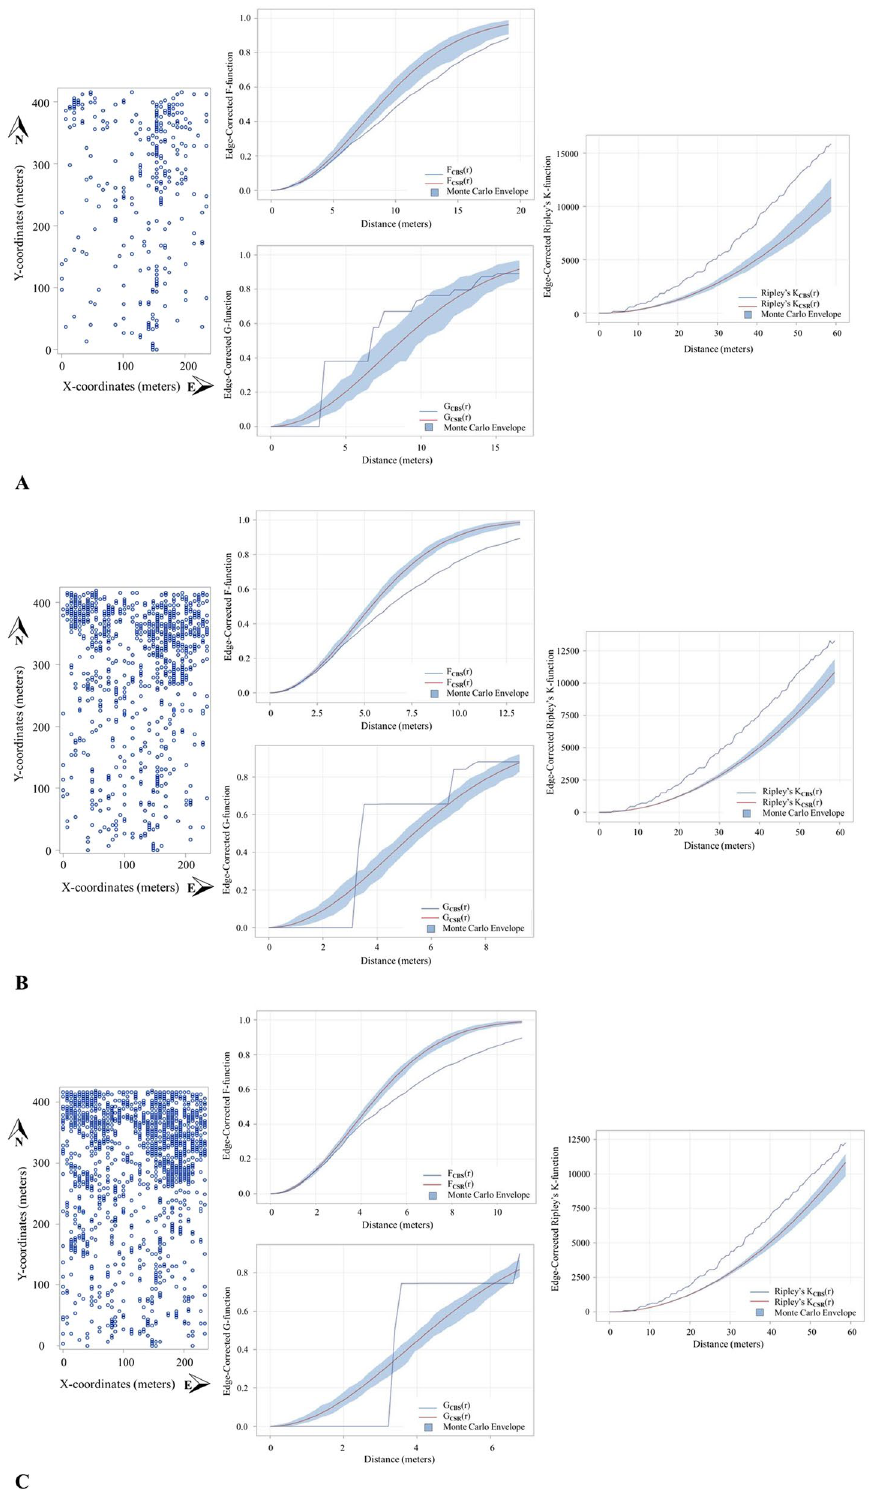
Figure 2. Grove II point pattern analyses. Comparisons of point pattern analyses for Groves II for three contiguous citrus seasons (Panel A) 2013–2014, (Panel B) 2014–2015 and (Panel C) 2015–2016. Each panel consists of a plot map of CBS positive trees (open circles; left), edge-corrected F- and G-functions (middle) and edge-corrected Ripley’s K-function (right). Positive trees contain at least one fruit with a single hard-spot lesion. Values of F CBS (r) < F CSR (r), and of G CBS (r) > G CSR (r) that falls outside of the Monte Carlo envelopes, indicate statistically significant clustering. For each graph, the red line corresponds to a Poisson process representing complete spatial randomness (CSR) and the blue shaded area is the Monte Carlo envelope that correspond to the 5th to 95th percentiles of CSR, F(r), G(r) and Ripley’s K(r) respectively for values based on randomizations of the original